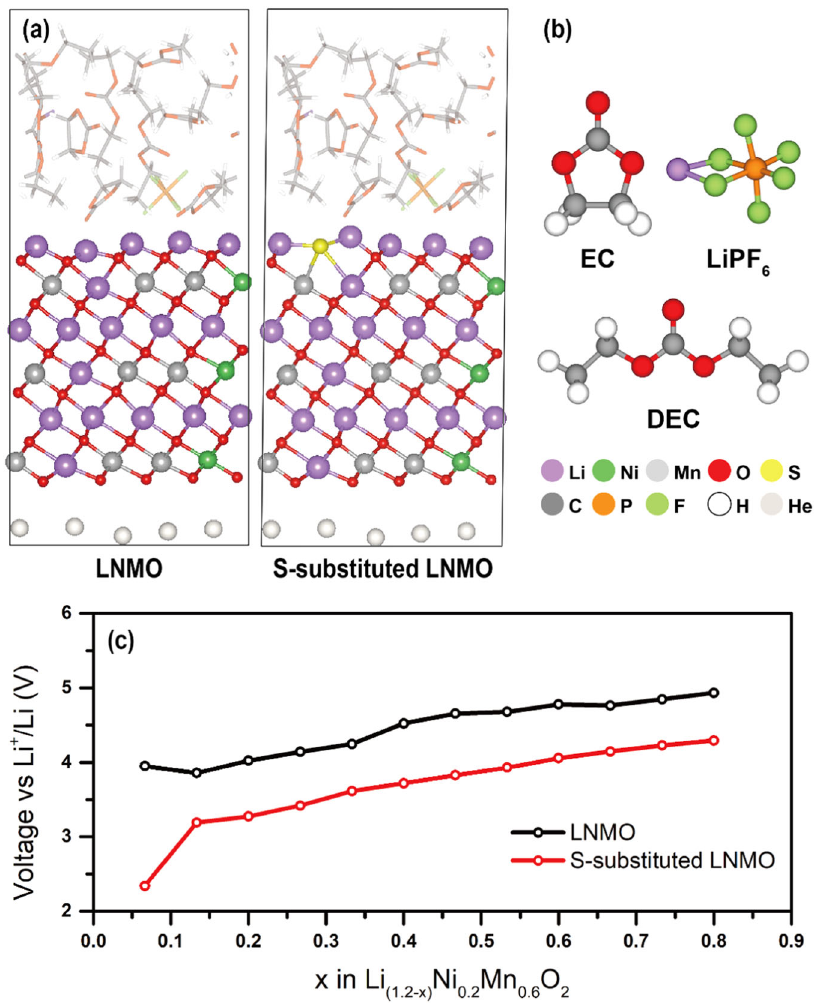
Fig. 1 Simulation models for AIMD calculations and the average intercalation voltage pro fi le. a Pristine and S-substituted LNMO (003) surfaces, and b electrolyte including Li salt (LiPF 6 ) and solvent mixture (EC/DEC). c Voltage pro fi le for the pristine and S-substituted LNMO (003) surfaces calculated at different delithiation levels. During the delithiation process, Li ions were removed from the fi rst- and second-layer LNMO (003) surface. After the removal of Li ions from both layers, the system was equilibrated for 5